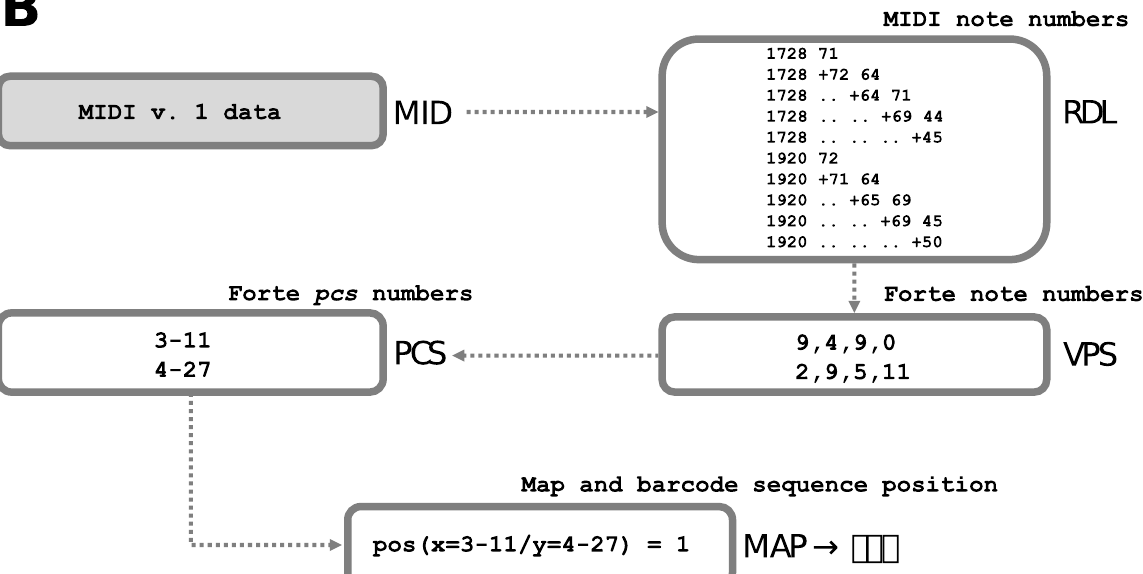
PLOS ONE | https://doi.org/10.1371/journal.pone.0280478 March 2, 2023 3 /